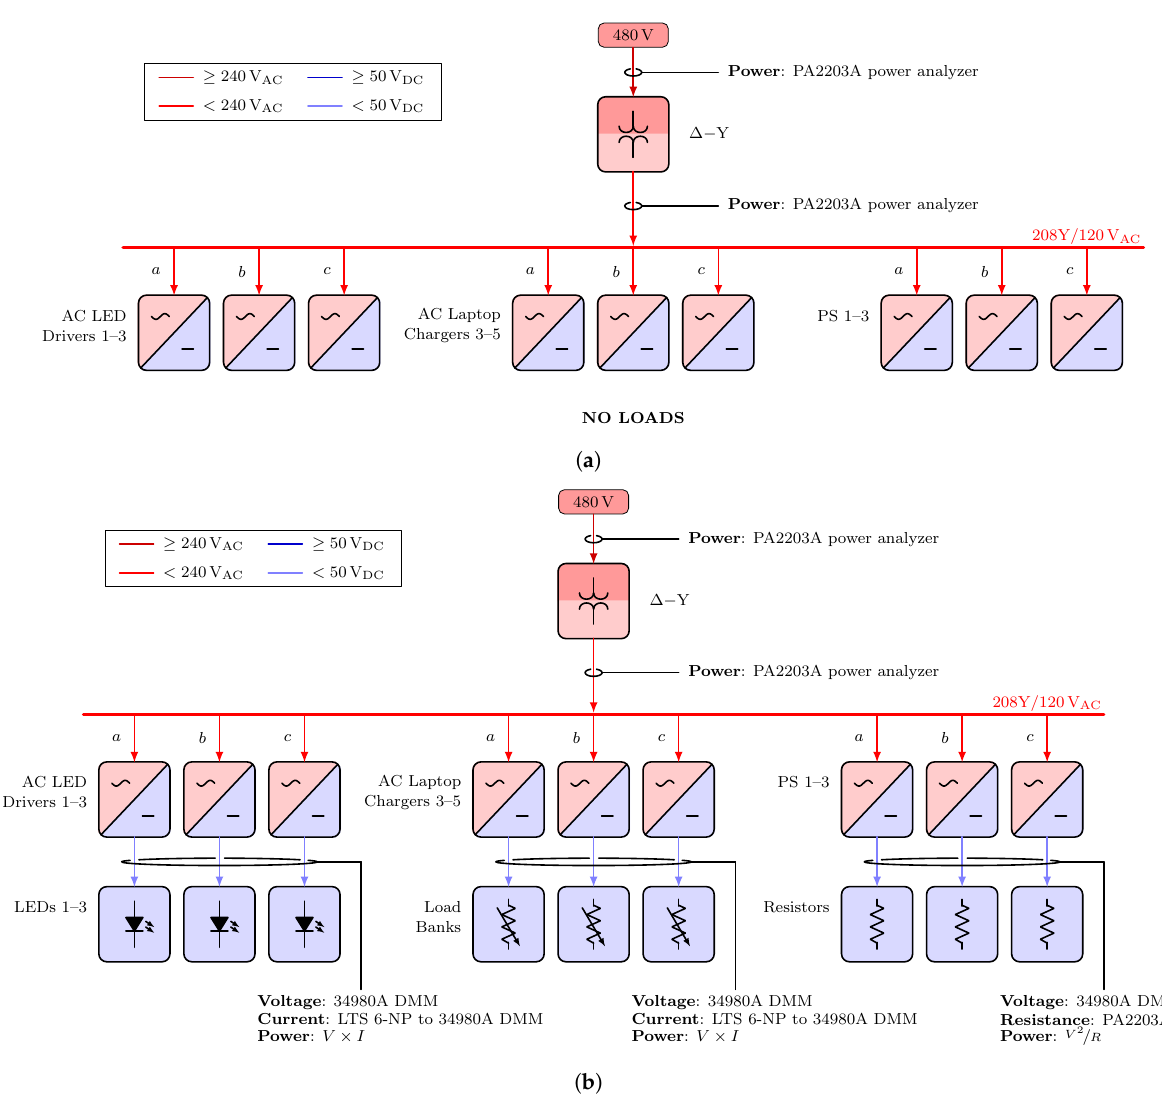
Figure A1. Electrical diagrams for Scenarios 1 and 2. ( a ) Electrical diagrams for Scenarios 1.1 and 2.1. ( b ) Electrical diagrams for Scenarios 1.2–4 and